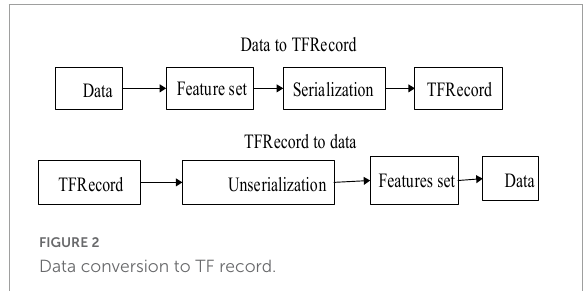
FIGURE2 Data conversion to TF